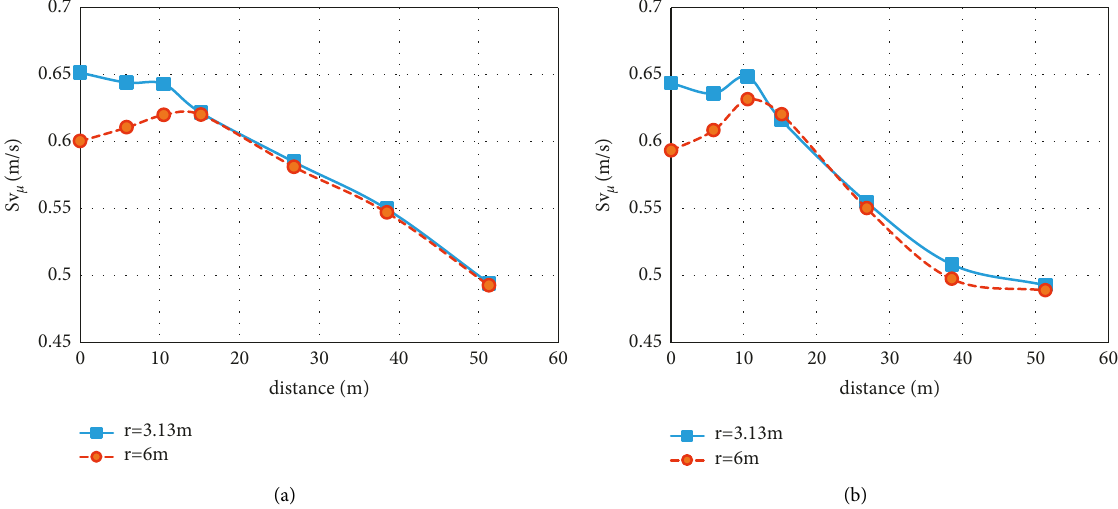
Figure 6: Effect of tunnel radius on ground surface velocity for models (a) 20 and 24 and (b) 30 and 32 of Table 1.